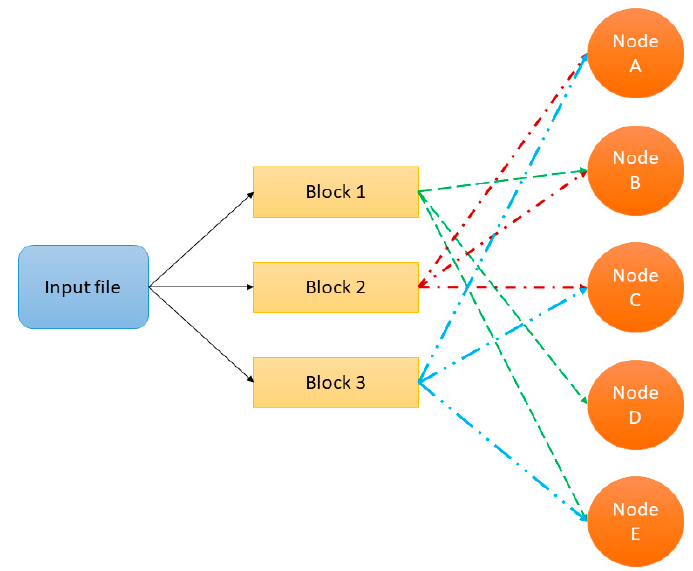
Figure 2. Hadoop Distributed File System architecture for data storage.